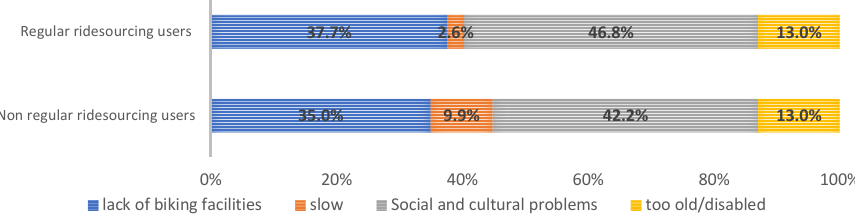
Figure 1. Reasons for not cycling among regular and non-regular ridesourcing users in the Tehran sample .